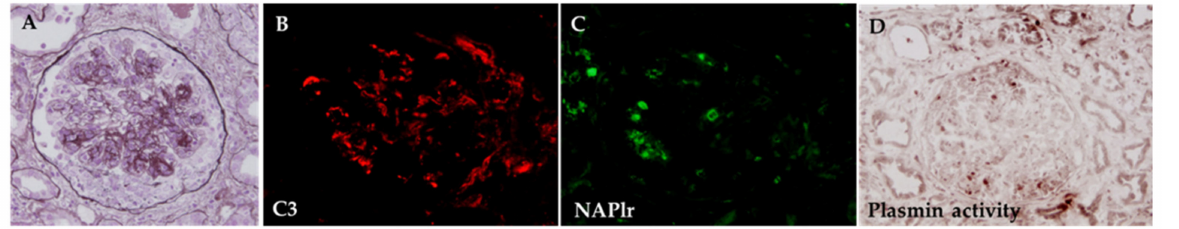
Figure 20. Kidney biopsy findings for case 7 in Table 8. ( A ): Mesangial and endocapillary proliferation with double contours along the capillary walls and a cellular crescent (periodic acid-methenamine- silver stain, original magnification × 200). C3 ( B ) and NAPlr ( C ) were both positive in glomeruli, and their localization was essentially different. ( D ): In situ zymography showed that the glomerular distribution of plasmin activity was similar to that of NAPlr staining. Photographs are cited from a previously published report [83], where details of all the staining methods have been